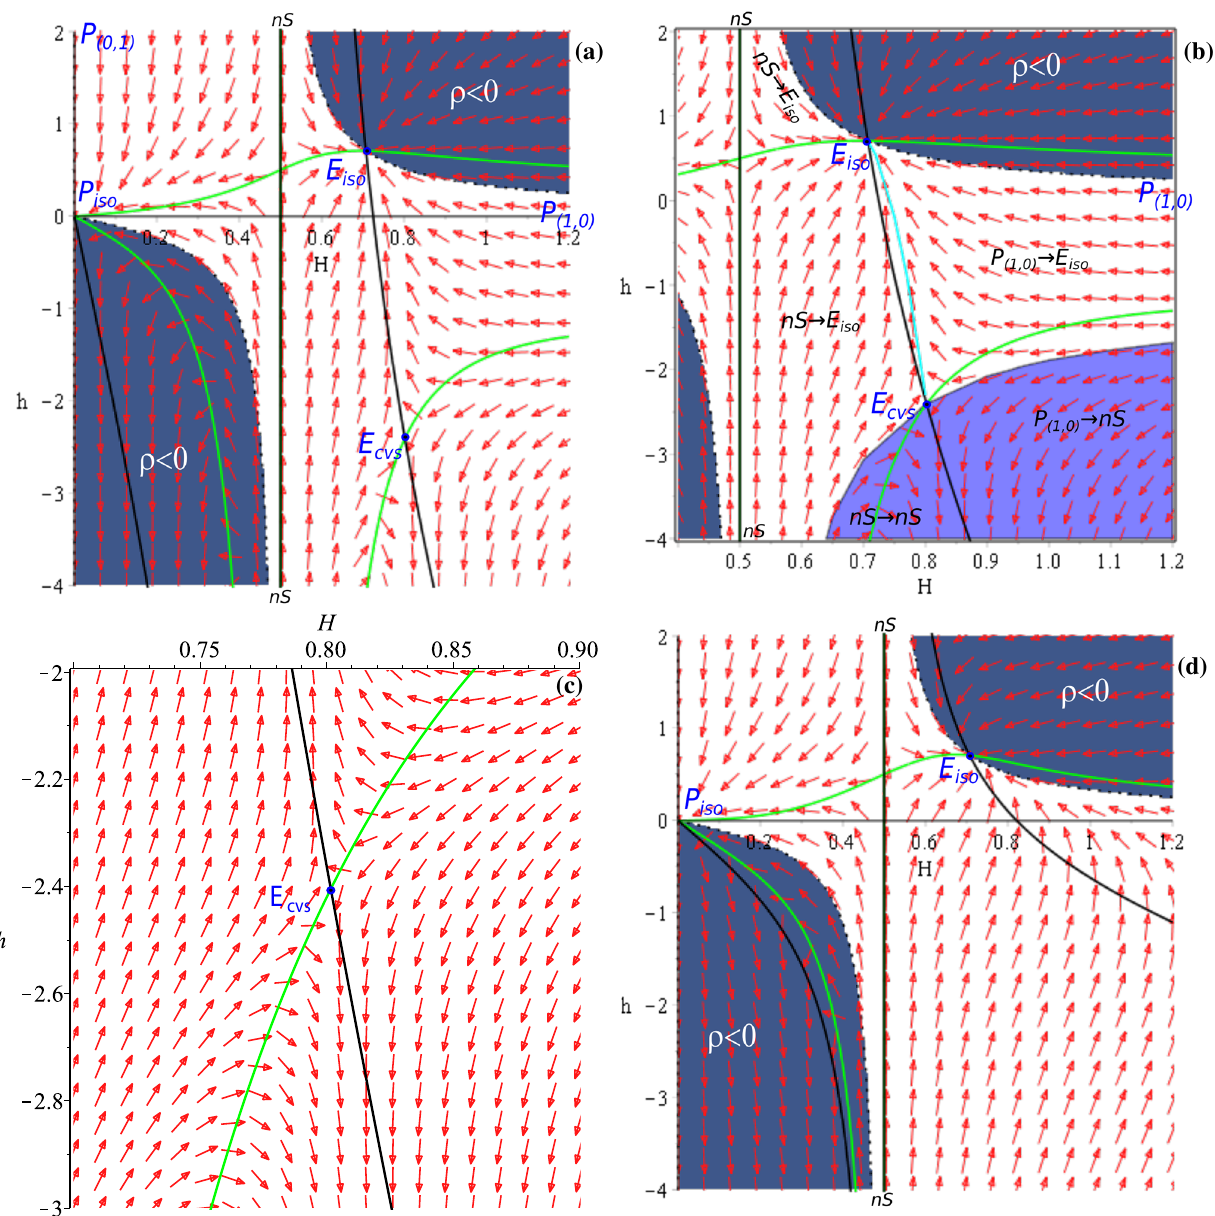
Fig. 3 Phase portraits for D = 1 α < 0, ω > 0 case: 0 < ω < 1 / 3 general view on a , 0 < ω < 1 / 3 regimes for H > H ns on b , vicinity of CVS on c and ω > 1 / 3 general view on d . Blue area corresponds to the initial conditions associated with specific regime. Light blue line